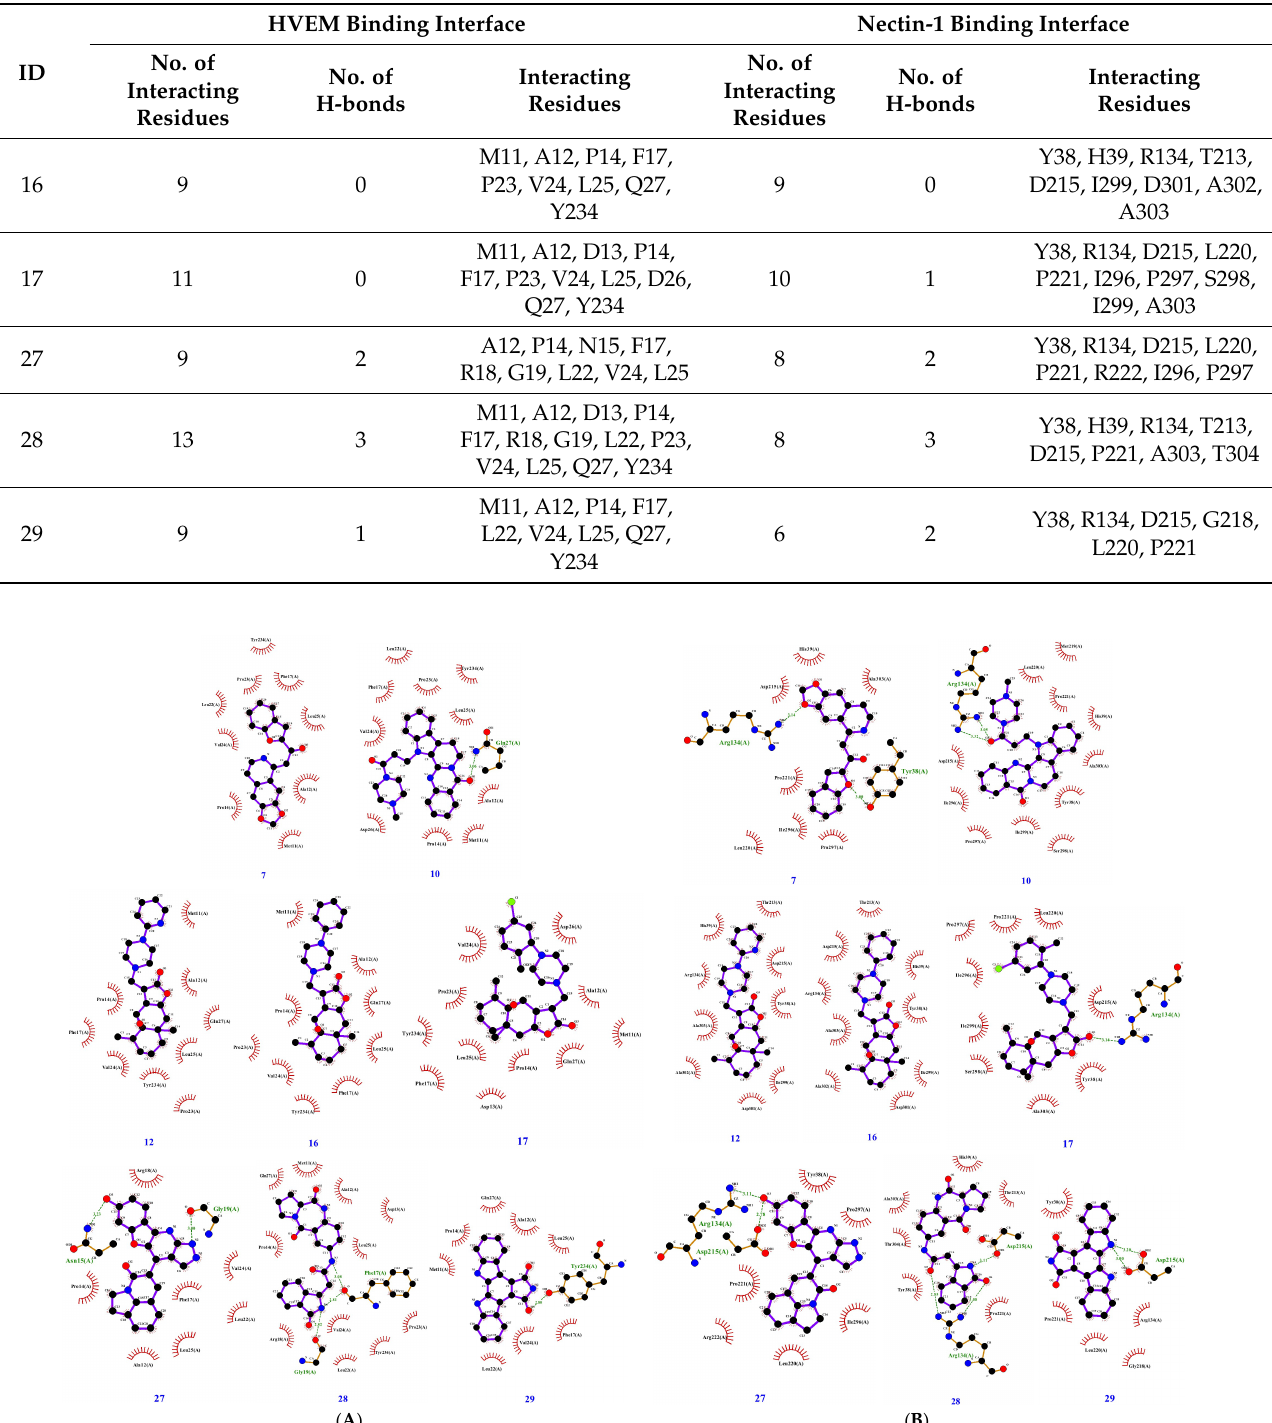
Figure 3. Binding interaction diagrams of the eight compounds selected for in vitro validation with the (herpes virus entry mediator) HVEM ( A ) and nectin-1 ( B ) binding interfaces of HSV-1 glycoprotein D as predicted by molecular docking. Red lines represent hydrophobic contacts, and broken green lines represent hydrogen bonds, with distances in